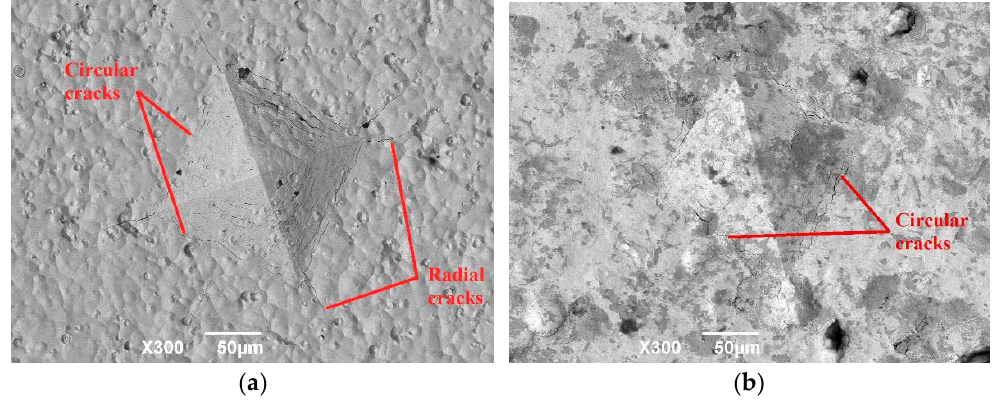
Figure 12. Morphology of track on the ( a ) ZrN and ( b ) ZrN+SP layers.